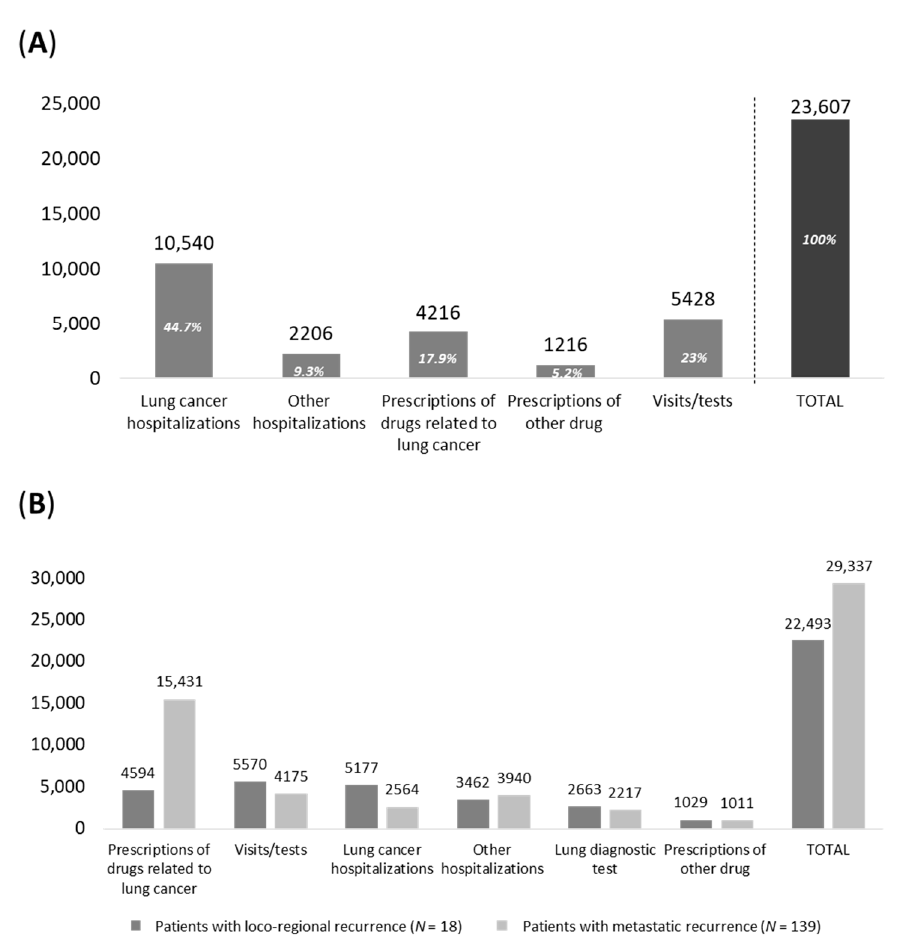
Figure 5. Healthcare costs during ( A ) the first year of follow-up among alive eNSCLC patients who were treated with chemotherapy after surgery in stage II–IIIA (study period January 2015–June 2019) and ( B ) during first year after recurrence among alive patients—study period January